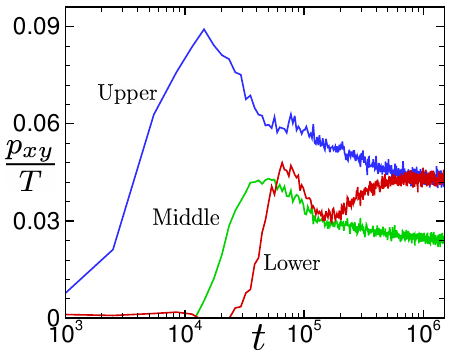
Figure 11. Time evolution of the local shear stress (shown in Figure 10c) divided by the local temperature (shown in Figure 10b), p xy / T for p w = 0.05.